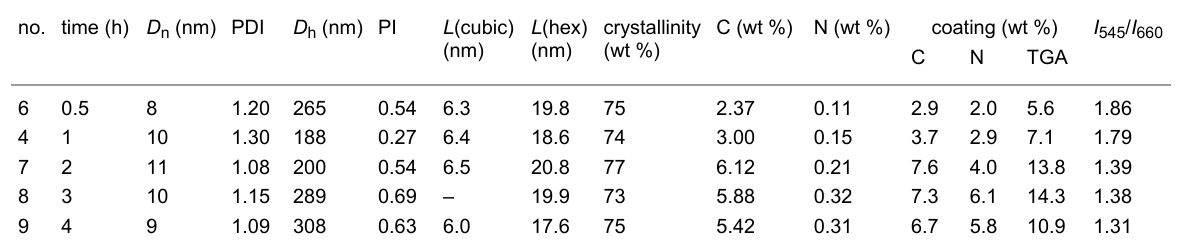
Table 2: Effect of reaction time on OM–NaYF 4 :Yb 3+ /Er 3+ nanoparticles prepared at 330 °C. no. time (h) D n (nm)